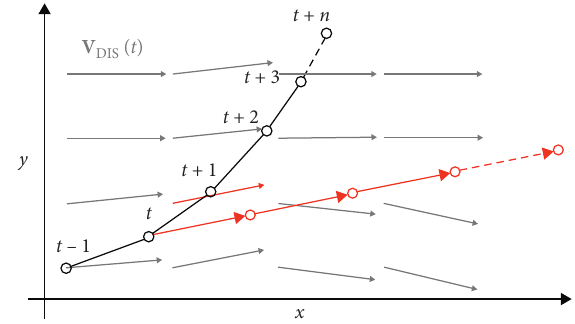
( t,p ) (light red t DIS t location and